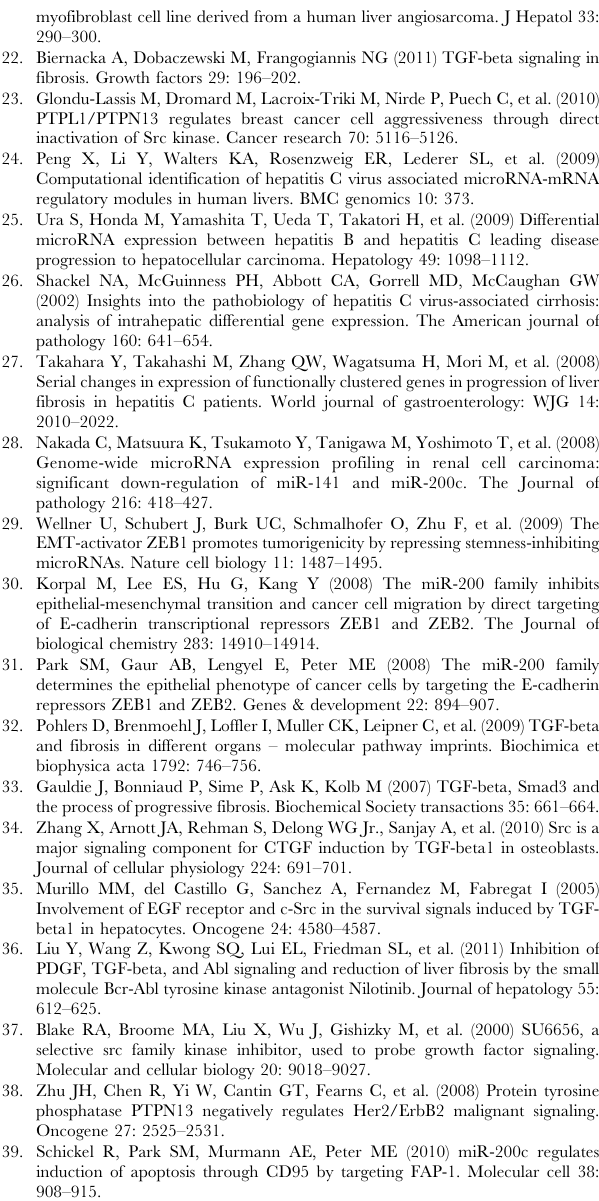
Table S1 Transcription profile of the chronic HCV liver. Total RNA was isolated from the liver biopsies and mRNA expression analysis was done using the Illumina HumanHT-12 v3 Expression BeadChips array that contains (48000) probe sets. Gene expression levels in the samples were normalized based on the 16s ribosomal RNAs and housekeeping gene expression. PARTEK analysis software was used to analyze the differential expression profile of the genes. Changes in gene expression level of 2-fold or more in the HCV samples compared with the normal controls with p value , 0.05 (based on ANOVA analysis) were